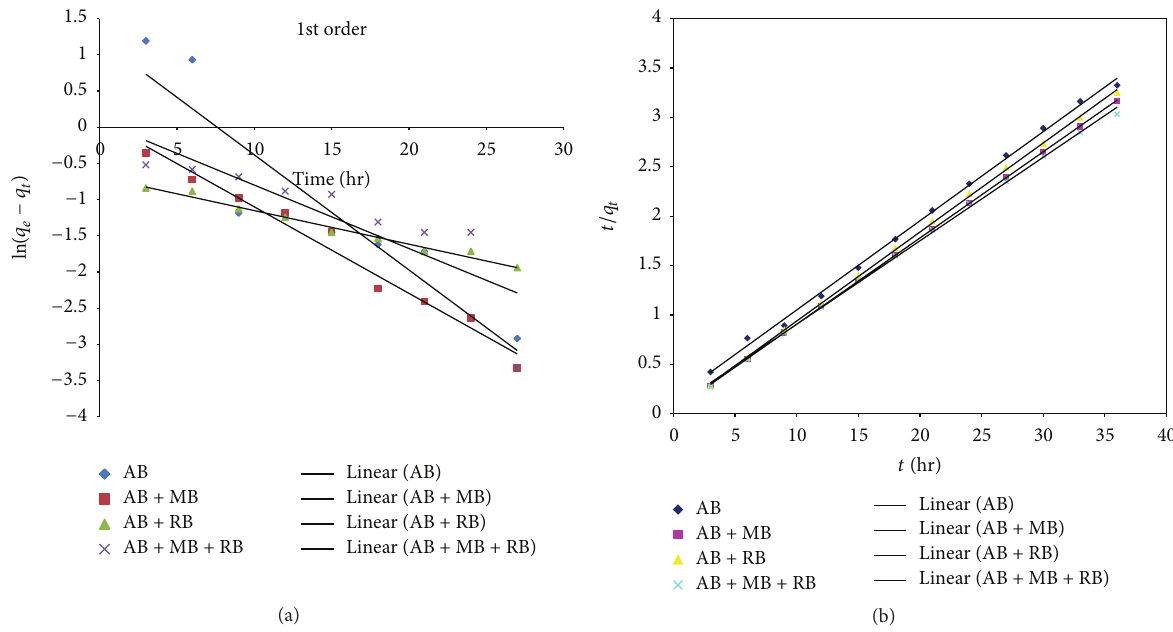
Figure 8: Plots of (a) pseudo-first-order and (b) pseudo-second-order kinetics for adsorption of Acid Blue 161 onto RSD in single and mixture